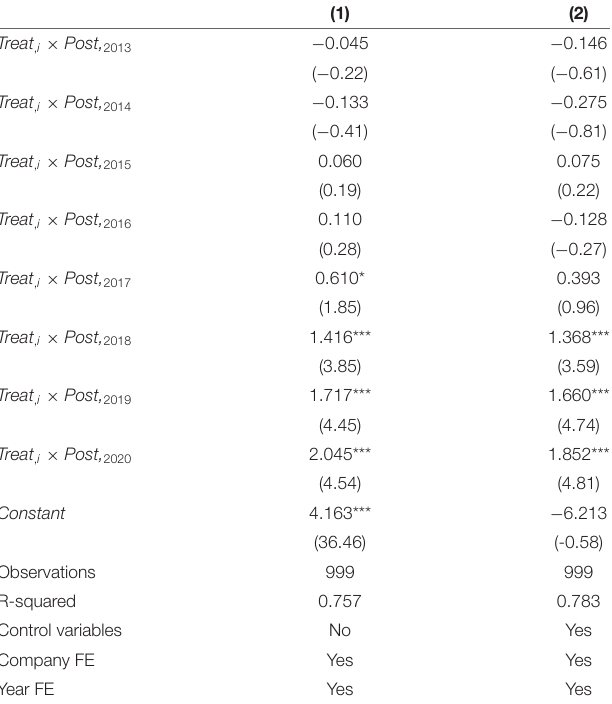
TABLE 4 | Parallel trend test